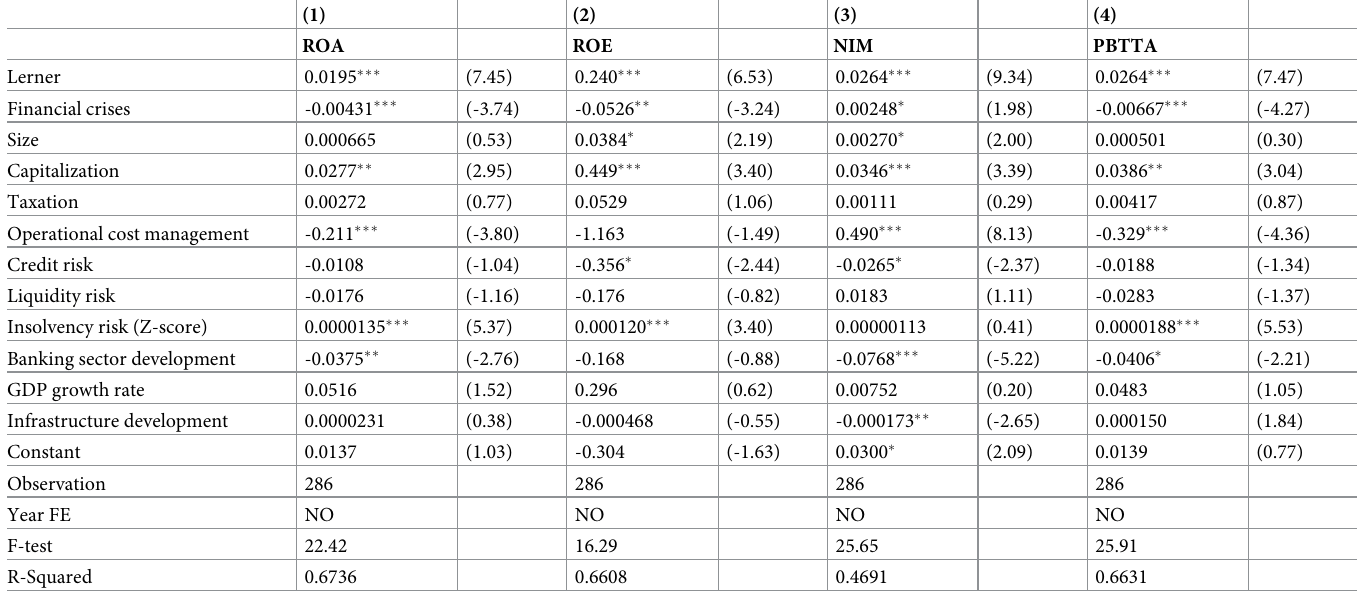
Table 9. Fixed effect model when the competition is measured with the Lerner